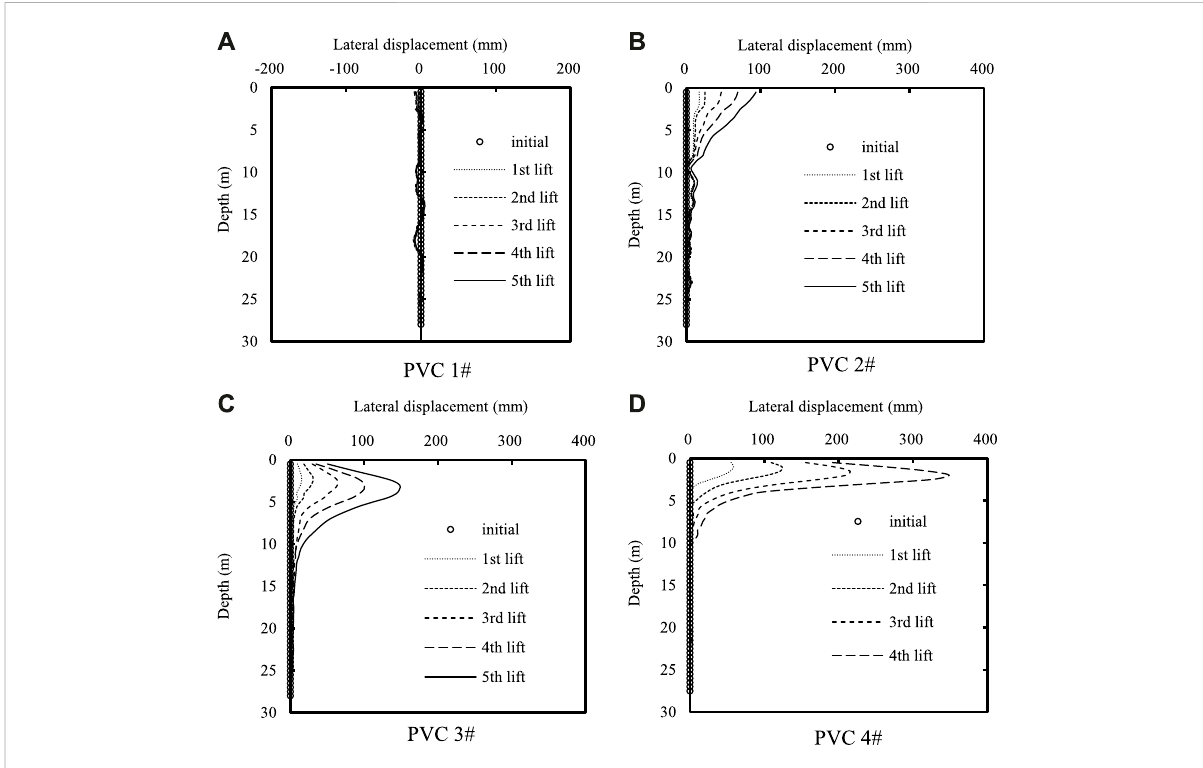
FIGURE 5 Horizontal displacement of the soil measured by (A) PVC 1#, (B) 2#, (C) 3#, and (D) 4# with depth under different surcharge loading